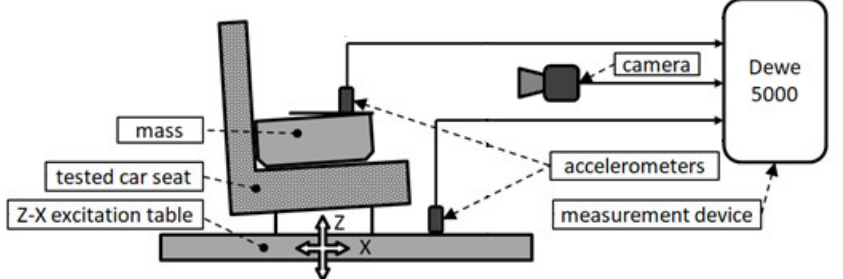
Figure 9. Block diagram of the measurement arrangement.